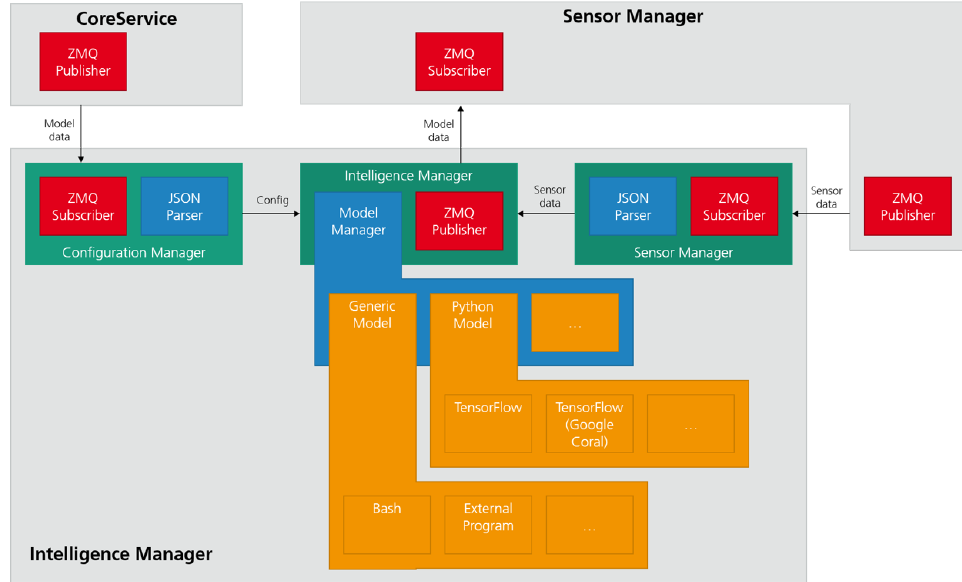
Figure 4. Intelligence Manager high level block